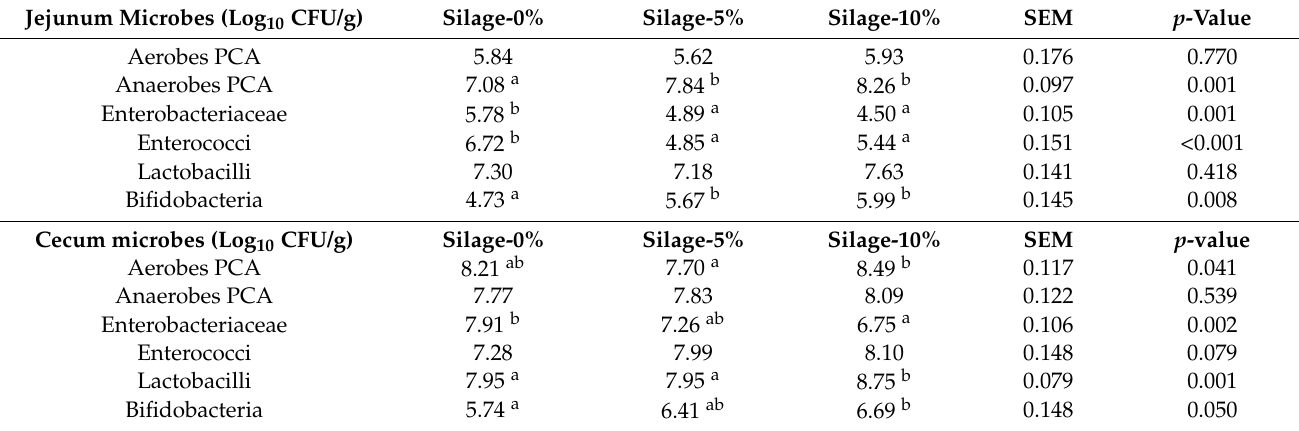
Table 4. Effect of silage supplementation on broiler intestinal microflora populations.